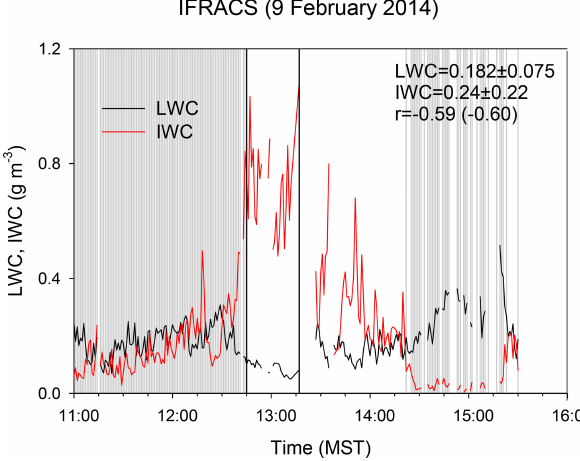
Figure 6. Time series of LWC and IWC on 9 February 2014 during IFRACS. The high-ice period is from 12:45 to 13:17MST. The low- ice periods are indicated by the shaded areas.